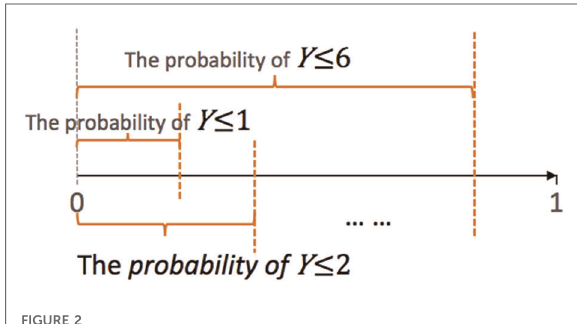
FIGURE 2 Graphical illustration of ordinal regression. Suppose the class labels range from 1 to 7. The ordinal regression trains 6 logistic models to predict the probability of Y ≤ j , j =1, … ,6 . The parallel ordinal regression model assumes that these 6 sub-models share the same set of coef fi cients, whereas the semi-parallel model forces the (K-1) sets of coef fi cients to be similar and close to